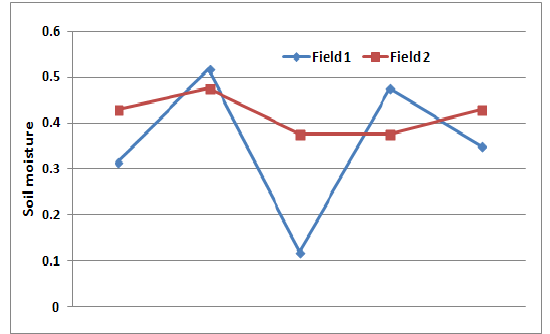
Fig.4. Soil moisture in first 5cm layer of soil surface in two fields of sugarcane for the collected samples in two fields of sugarcane. Fig. 3 shows the values of permittivity of soil i.e., ε 2' for